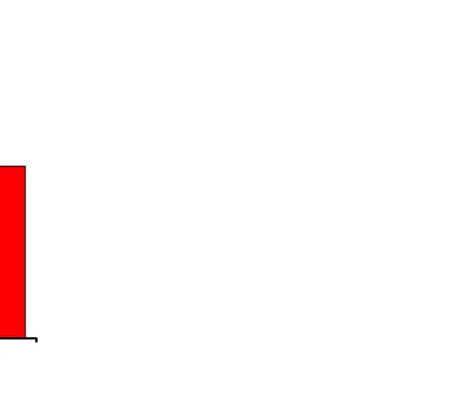
Figure 8. The wavelength dips shift of grease sample 00#, 02#, 82# and 83# at coarse vacuum of ~20 Pa.